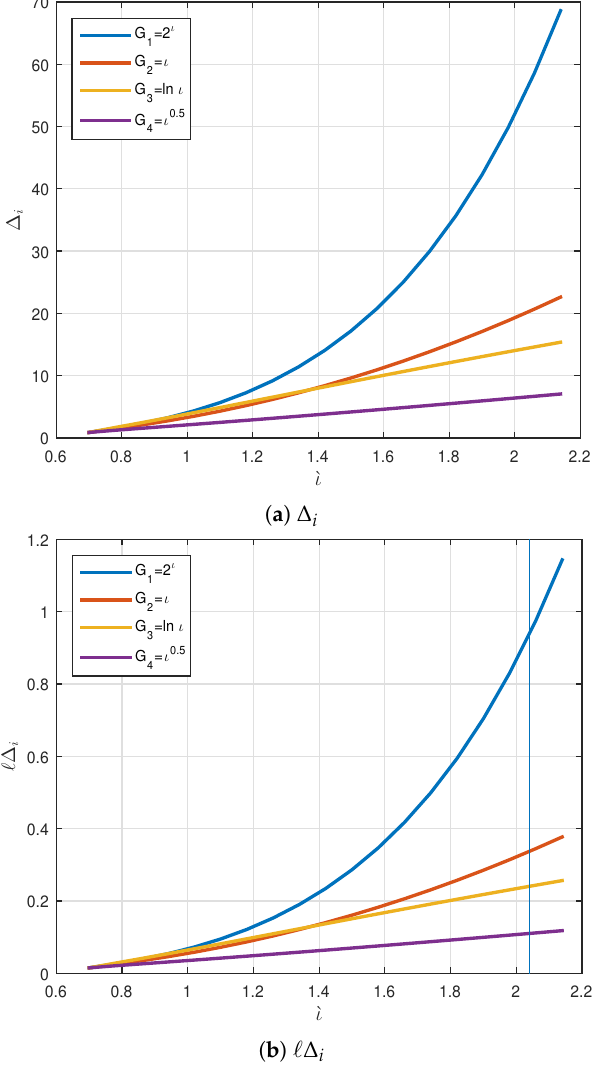
Figure 1. Graphical representation of ∆ i and (cid:96) ∆ i for ` ι ∈ [ 0.7,2.1 ] in Example